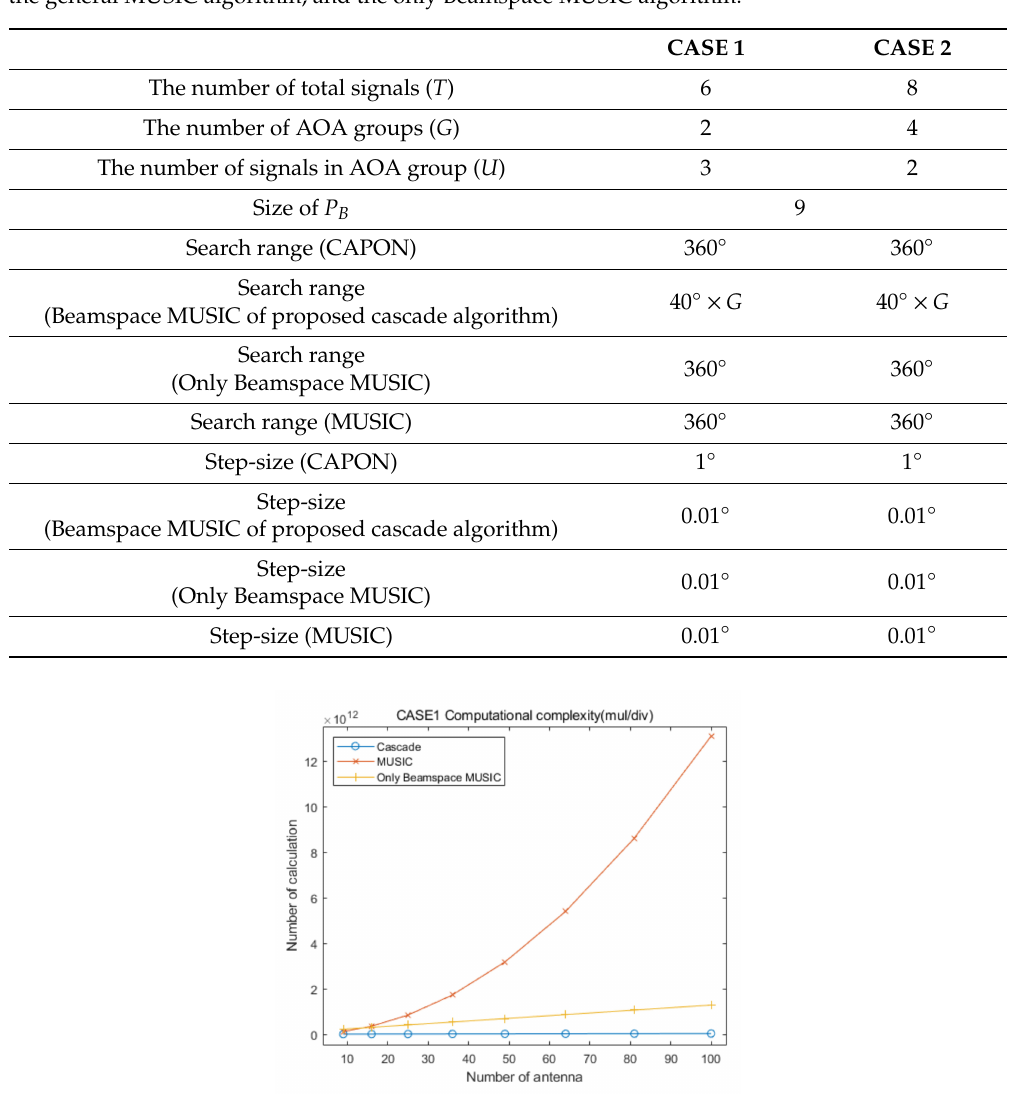
Figure 21. Curves for comparing multiplication / division computational complexities of the proposed cascade algorithm, the general MUSIC algorithm, and only Beamspace MUSIC, versus the number of antenna elements, for CASE